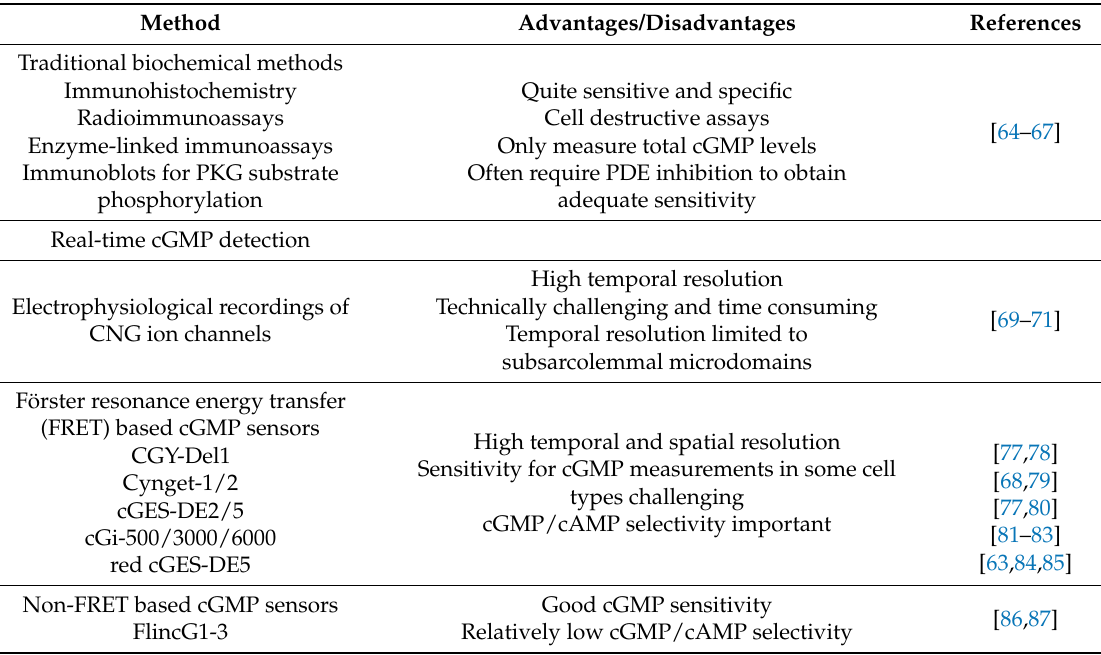
Table 1. Techniques to measure cGMP in living cells and